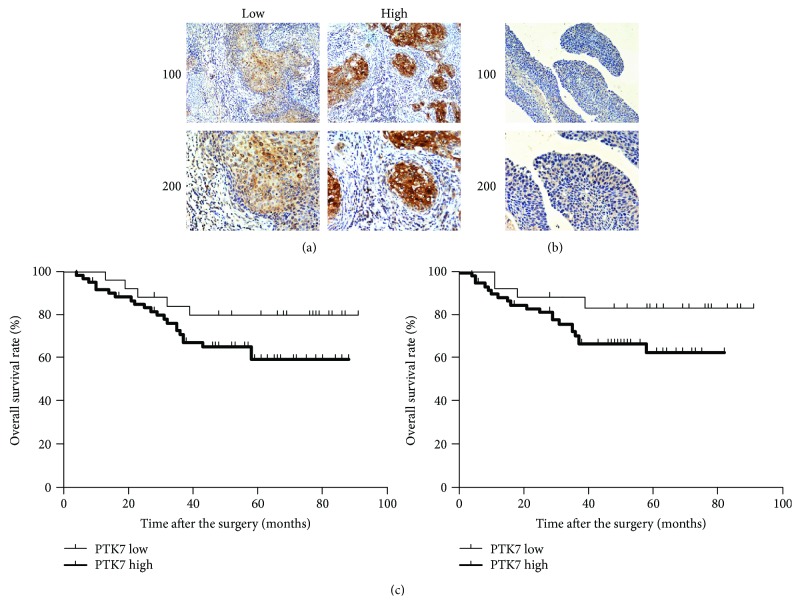
Overexpressed PTK7 expression connected with poor prognosis. (a) Low and high PTK7 protein expressions in the tumor tissues by IHC were shown. (b) The negative PTK7 protein expression in the paired tumor-adjacent tissues by IHC. (c) The overall survival and progression-free survival in our clinical cohort: the high PTK7 protein expression level group was significantly associated with shorter progression-free survival compared to the low expression group (∗P < 0.05, respectively).